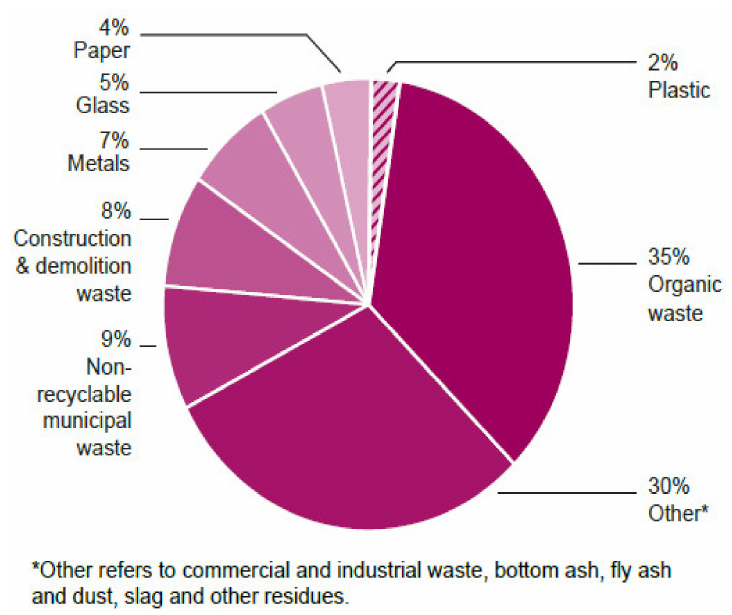
Figure 1. Breakdown of general waste generated in South Africa in